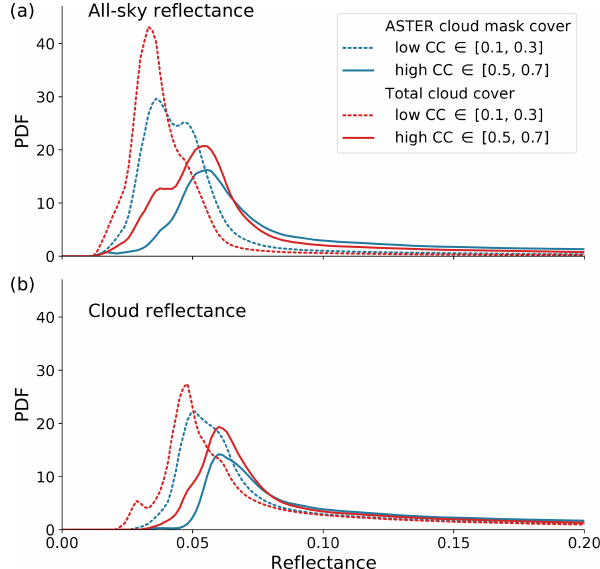
Figure 9. Combined probability density functions (PDFs) of (a) all- sky reflectance from ASTER p ( R | CC), binned according to the to- tal (red) and cloud-mask (blue) cloud cover (CC). We define two representative cloud cover ranges: low CC (0.1 to 0.3) and high CC (0.5 to 0.7). Panel (b) shows the conditional probability of to- tal cloud reflectance p ( R | F TOTAL , CC), given that they are within the range of low or high CC. Compared to (a) , the distributions in panel (b) do not include the cloud-free contributions at low re-